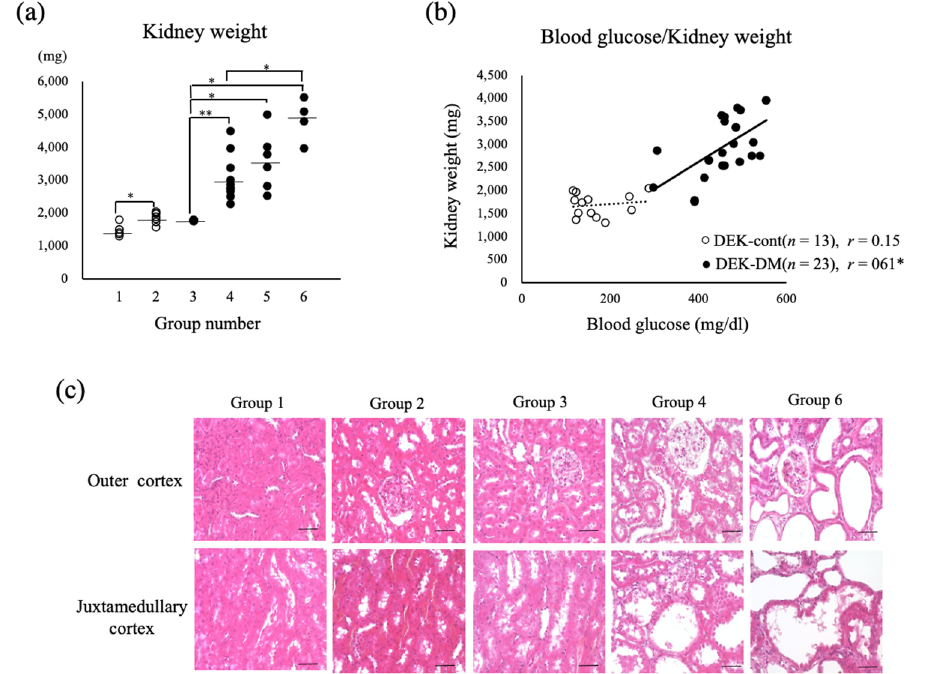
Figure 2. Association between kidney weight and blood glucose. ( a ) Scattergram showing mean kidney weights (mg) in individual DEK-cont (white circles) and DEK-DM (Block circles) rats classified into six age groups. Group 1: DEK-cont rats aged 15 weeks ( n = 6); Group 2: DEK-cont rats aged 30 weeks ( n = 7); Group 3: DEK-DM rats euthanized just after diabetes onset at age 15~22 weeks ( n = 3); Group 4: DEK-DM rats with late-onset (>18 weeks) DM euthanized at age 30 weeks ( n = 10); Group 5: DEK-DM rats with early-onset (~15 weeks) DM euthanized at age 30 weeks ( n = 7); Group 6: DEK-DM aged 42~45 weeks after having DM for 21–27 weeks ( n = 4). The horizontal bars represent averages. * p < 0.05, ** p < 0.01. ( b ) Relationship of blood glucose concentration (X-axis) and kidney weight (Y-axis) in individual DEK-cont (white circles) and DEK-DM (black circles) rats aged 15–30 weeks, with the correlation coefficient shown as r. * p < 0.05 for correlation. ( c ) Histology of outer and juxtamedullary cortices of representative kidneys in each group categorized in ( a ). H & E staining (scale bar = 100 μ m).